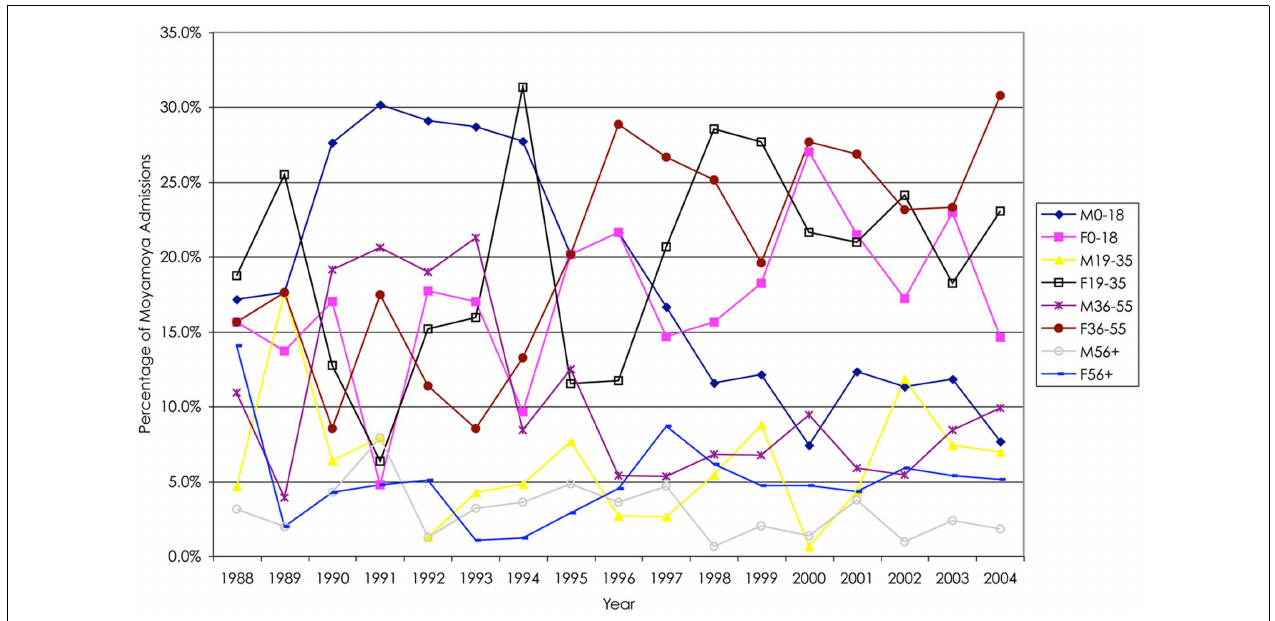
FIGURE 1 | Overall, there was a higher percentage of female relative to male hospital admissions for moyamoya; however, in general, there were fewer males and females over 55years of age who presented as hospital admissions. Of note after 1994, there was a decline in male hospital admissions in patients less than 19years of age.